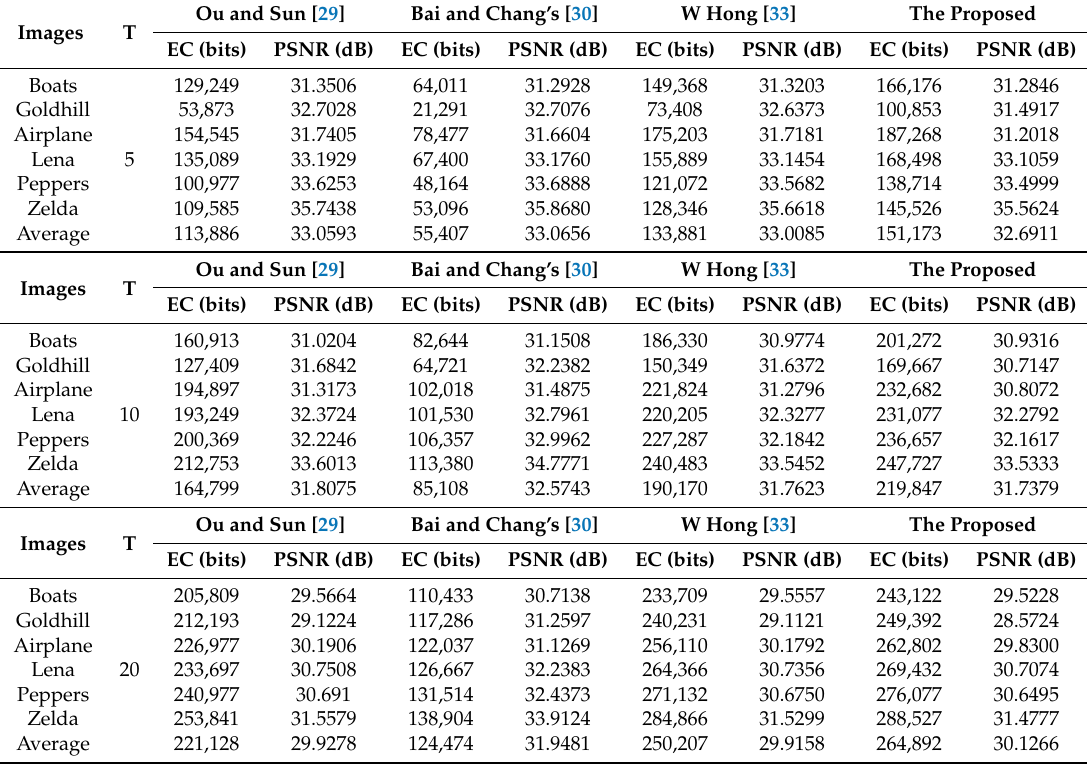
Table 1. PSNR and Embedding Capacity (EC) according to different thresholds T